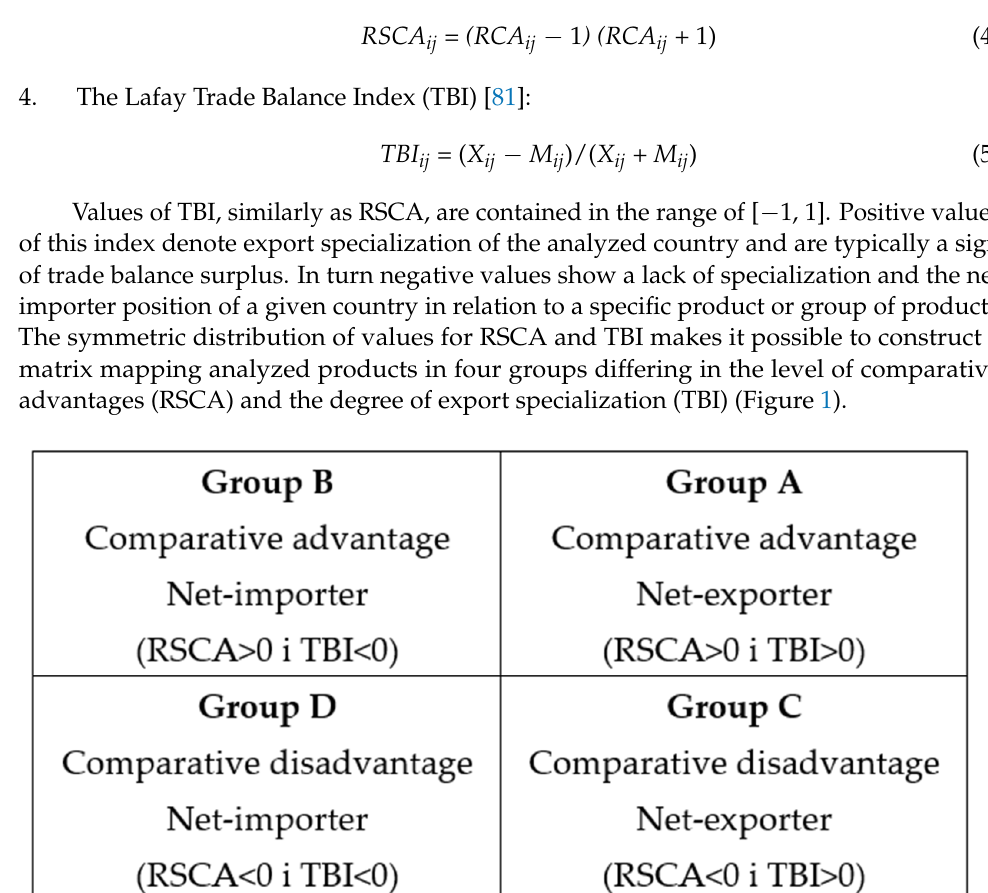
Table 3. Value and trade balance of agri-food trade between the EU and the US in 2010 and 2020 by the Combined Nomenclature (CN) sections (€ million). Section